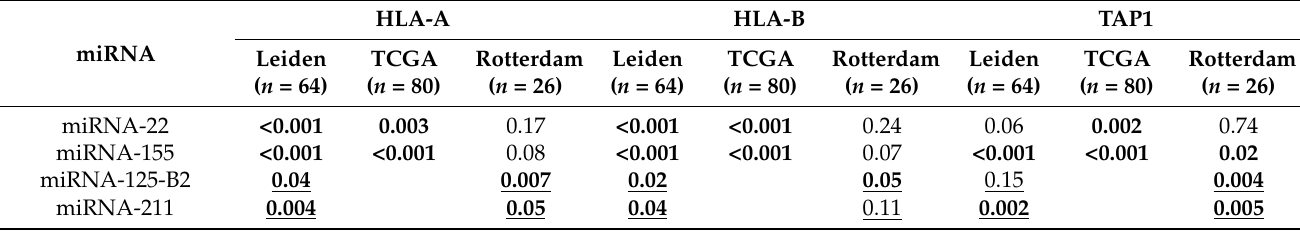
Table 1. Overview of correlations between different miRNAs and HLA-A, HLA-B and TAP1 in the Leiden cohort ( n = 64), TCGA cohort ( n = 80) and the Rotterdam cohort ( n = 26). r = two-tailed Spearman correlation coefficient. p ≤ 0.05 considered significant. Significant correlations are indicated as bold. Negative associations are